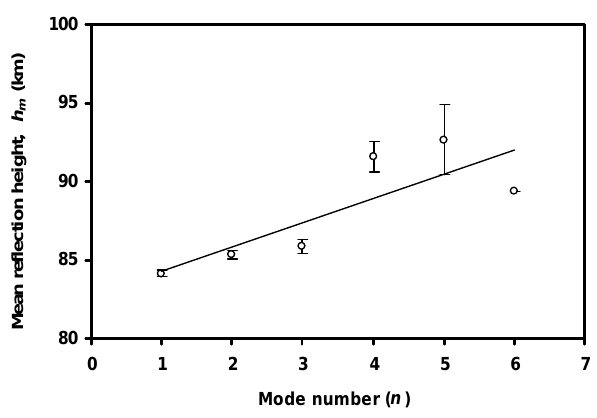
Fig.4. Variation of mean tweek reflection height, h m , with mode number, n . The error bars Fig. 4. Variation of average tweek reflection height, h m , with mode indicate standard error in the estimated height. The numbers in parentheses indicate the number, n . The error bars indicate a standard error in the estimated total number of tweeks analyzed.